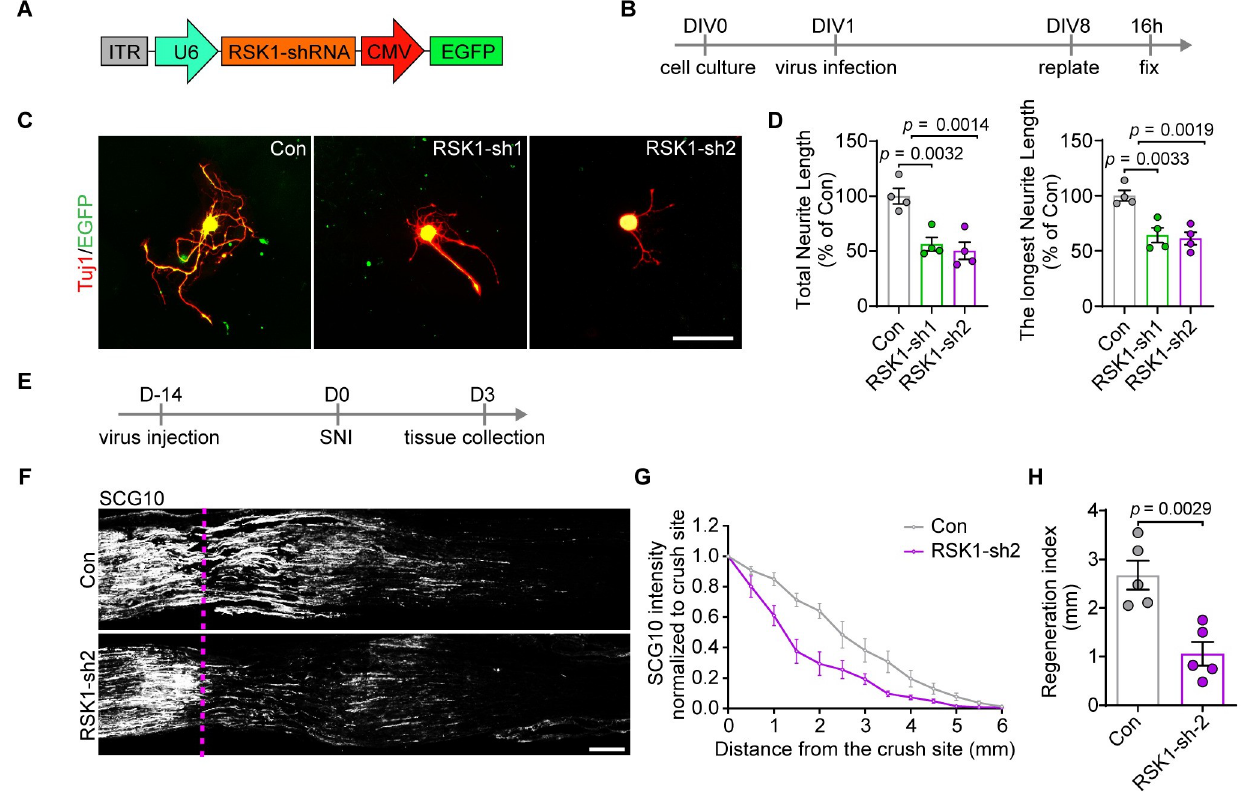
Fig 3. KD of RSK1 inhibits axon regeneration in vitro and in vivo. (A) A schematic representation of the AAV2/8-U6-shRNA-CMV-EGFP vector utilized in RSK1 KD experiments. (B) Timeline for RSK1 KD in DRG neurons at DIV1. (C) Representative images of cultured DRG neurons (EGFP and Tuj1 double positive neurons) infected with control AAV2/8 expressing scramble shRNA or AAV expressing shRNA1 (RSK1-sh1) or RSK1-sh2 to knock down RSK1. Scale bar, 100 μ m. (D) Quantification of the total and longest neurite outgrowth per neuron relating to (C) (mean ± SEM, 1-way ANOVA, Dunnett post hoc test, n = 4 biologically independent experiments, approximately 50 cells/experiment on average). (E) Timeline for RSK1 KD in vivo and SNI. (F) Representative longitudinal sections from injured sciatic nerves. The crush site is indicated by a purple dotted line. Scale bar, 500 μ m. (G) Normalized SCG10 intensity plotted in function of the distance from the crush line ( n = 5 rats per group). (H) Axon regeneration in injured rats was quantified by regeneration indices obtained from SCG10 immunostaining on day 3 after crush injury (mean ± SEM, unpaired 2-tailed t test, n = 5 rats per group). The data underlying all the graphs shown in the figure are included in S1 Data. DIV1, 1 day in vitro; DRG, dorsal root ganglion; KD, knockdown; RSK1, ribosomal S6 kinase 1; SEM, standard error of the mean; SNI, sciatic nerve injury.